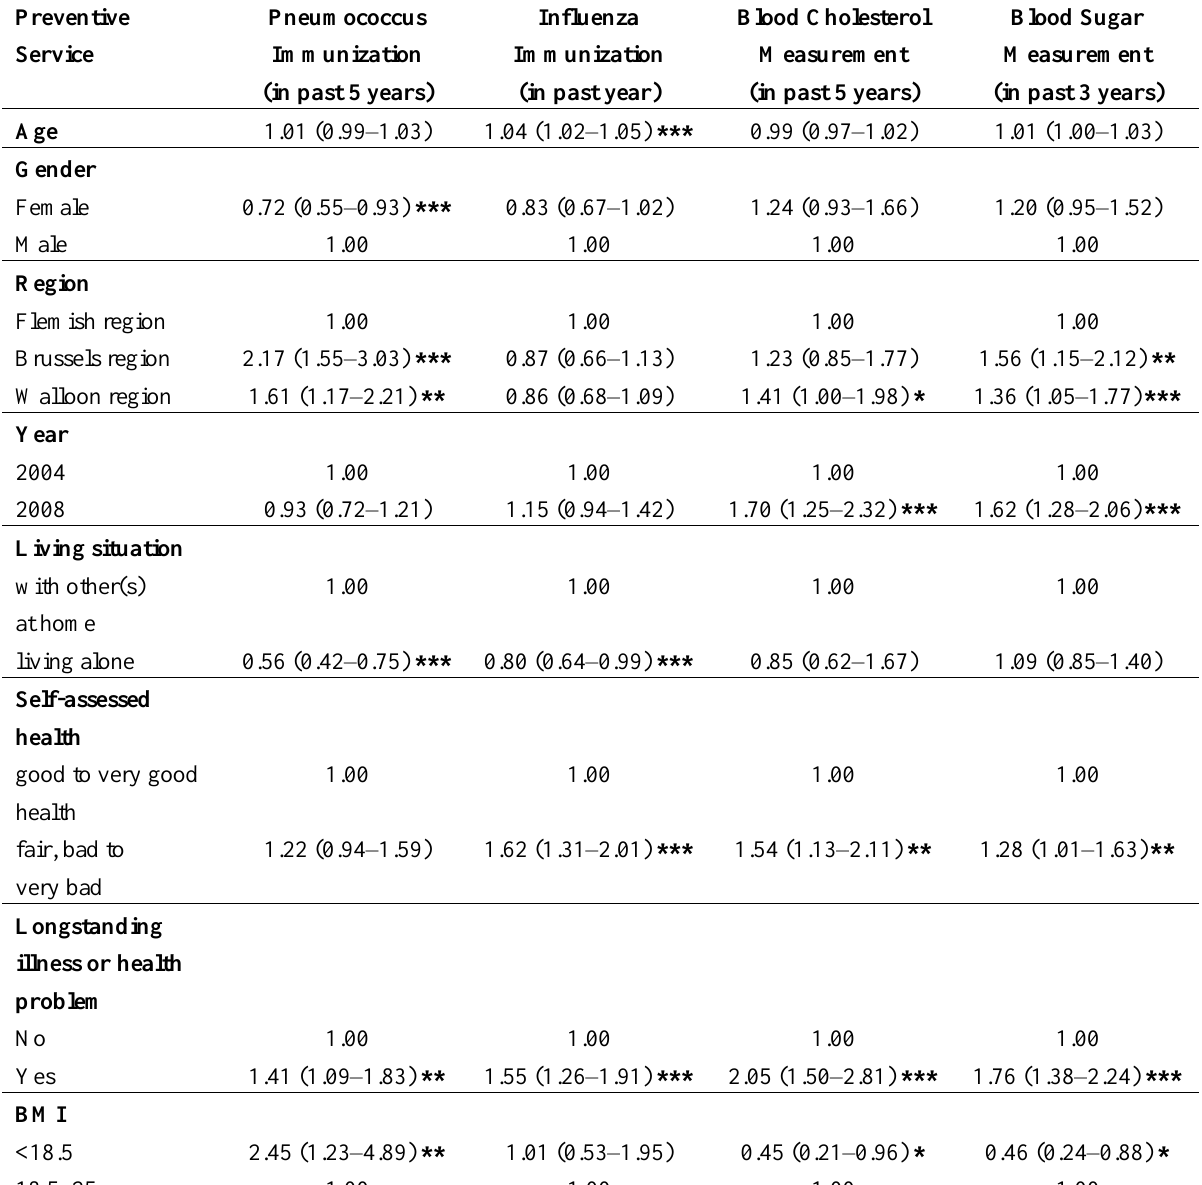
Table 2. Use of preventive services by respondents 65 years and over (n = 1,649) according to sociodemographic variables, health and socioeconomic status, and after adjustment for age and